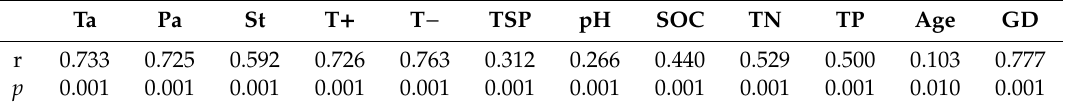
Correlations between EM fungal community composition and climate factors / soil properties / stand age / geographical distance assessed by Mantel test.